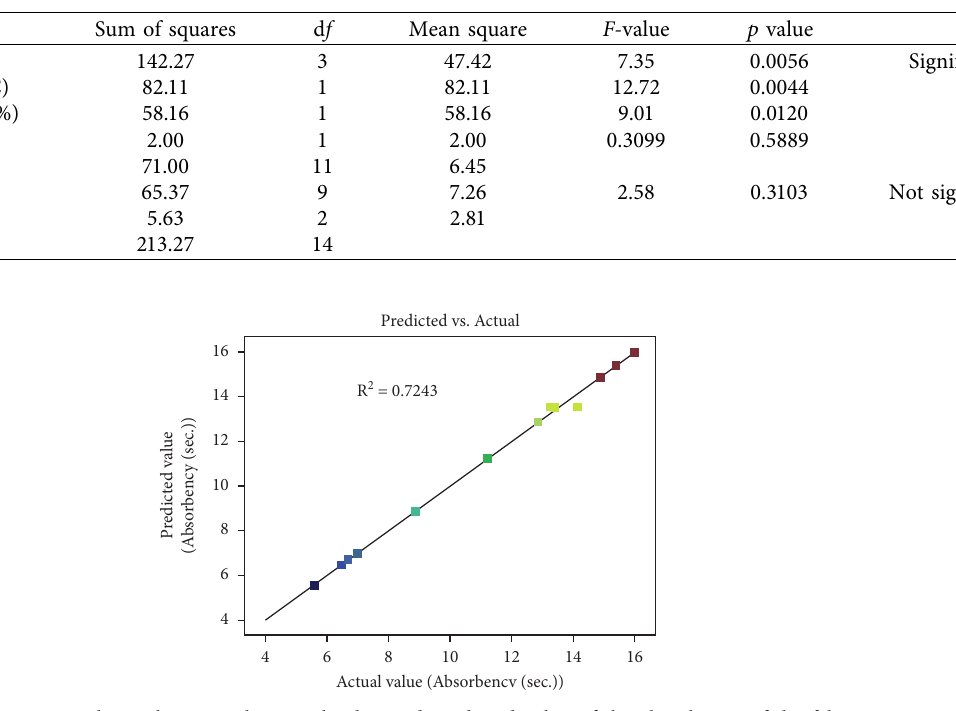
Table 2: Analysis of variance (ANOVA) for water absorbency of enzyme-treated dyed fabric.